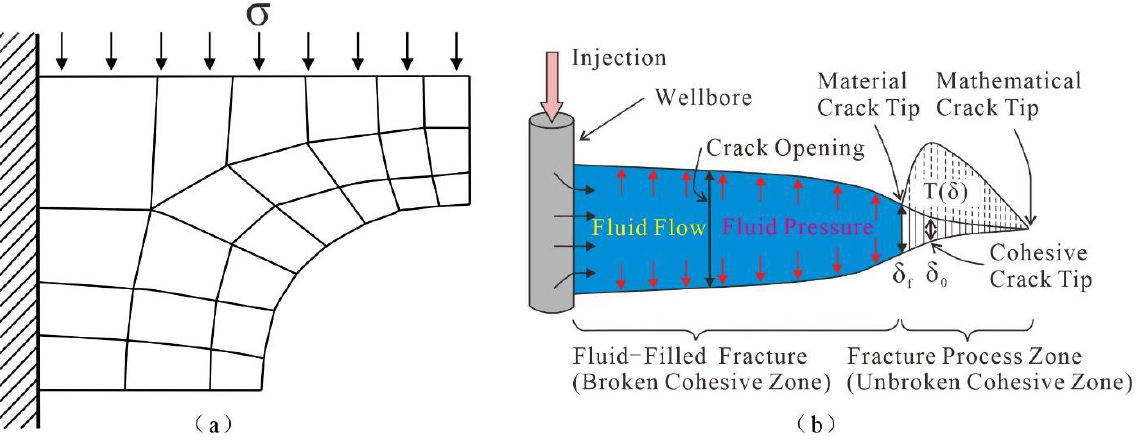
Figure 3. Simulation of hydraulic crack propagation by finite element method [28,87]: ( a ) Mesh generation by Finite Element Method (FEM); ( b ) Embedded cohesive zone in a hydraulic fracture, T, δ, δ0 and δ f represent traction tensor, displacement jump, and equivalently the separation and traction, respectively.